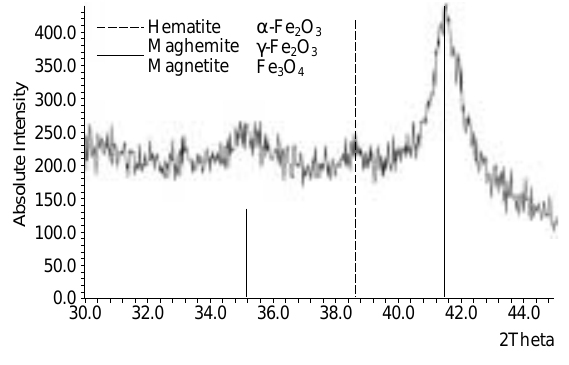
Fig. 21 XRD graph of iron oxide/ silica